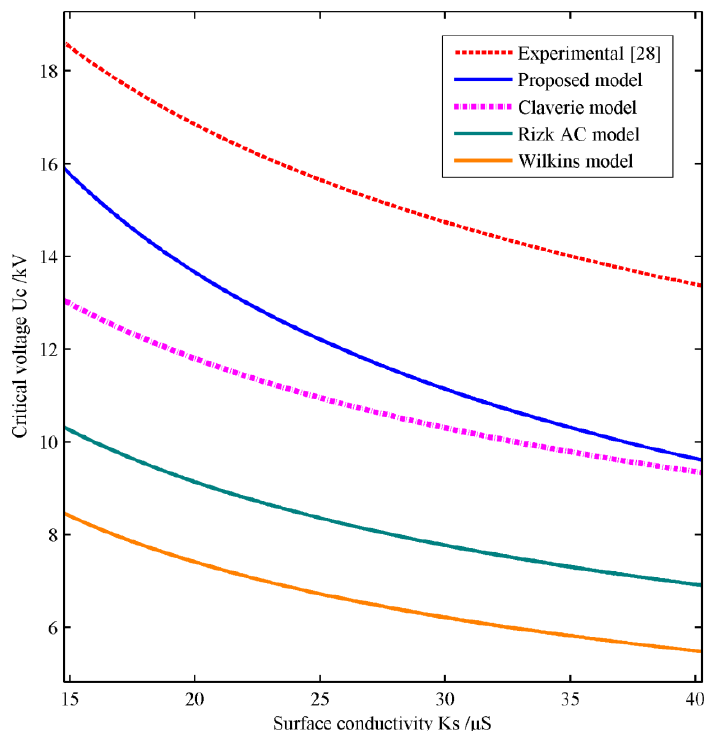
Figure 6. The relationship between surface conductivity and critical flashover voltage for various